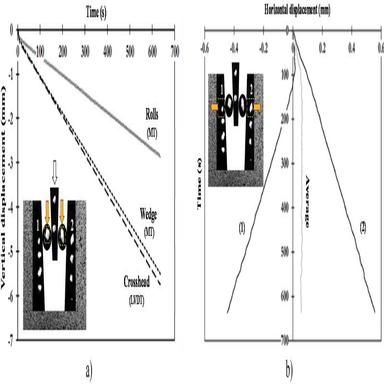
Monitoring of loading parts by Mark Tracking during a WST: a) vertical displacement of the crosshead, of the wedge and of the two rolls versus time, b) horizontal displacements of Mark 1 and 2 deposited on the two metallic supports and average of these supports displacements.